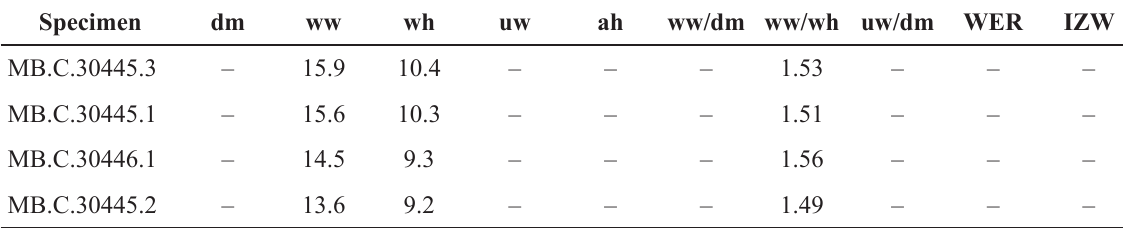
Table 2. Conch dimensions (in mm) and ratios of Stroborineceras insalahensis gen. et sp. nov.